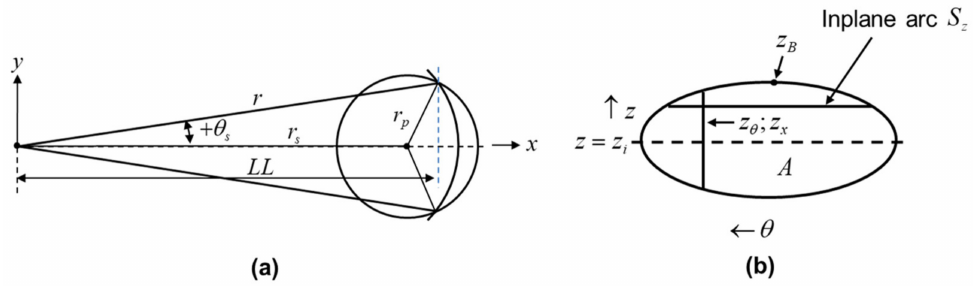
Figure 1. Cylindrical plane cutting through the sphere: ( a ) top view of plane at z = z i and ( b ) side view. The cylindrical plane cuts through the sphere when